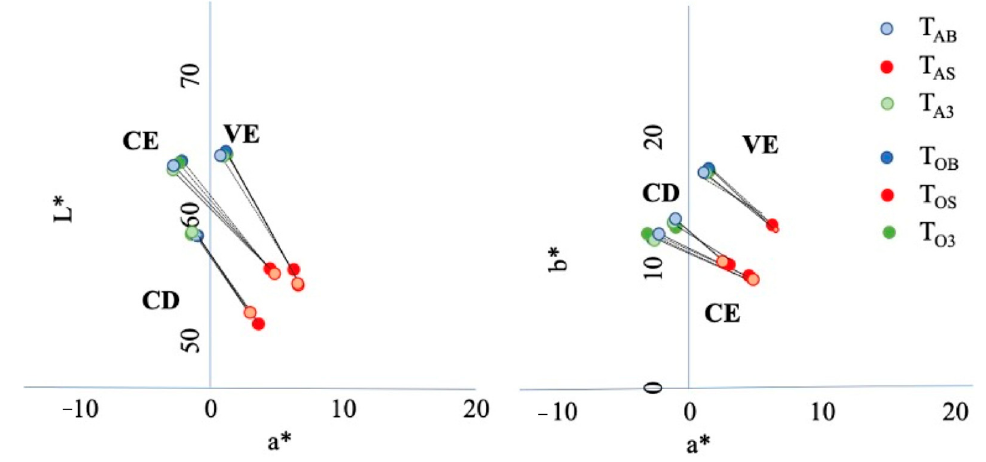
Figure 5. The changes in L *, a *, and b * between base line to staining those between staining and bleaching.